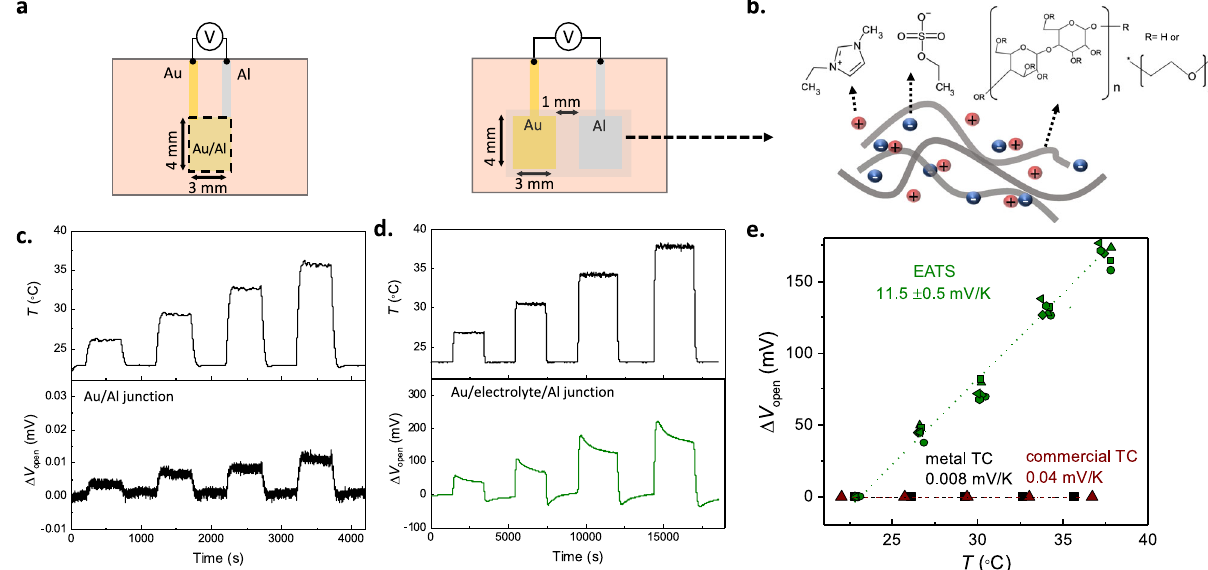
Fig. 1 Demonstration of the EATS and comparison with traditional TCs. a Schematic illustration of an Al/Au junction (left) and the EATS device (right). The Al/Au junction device consists of 20 nm-thick aluminum and gold layers overlapping in a 12 mm 2 area. For the EATS device, the Au and Al electrodes are separated and bridged by an electrolyte (shaded region, with areas overlapping with the electrodes of 12 mm 2 ). b Schematic illustration of the gel-like electrolyte used in EATS a and the chemical structures of the compositions in the gel. c Variations in open-circuit voltage of an Al/Au junction (bottom panel) upon controlled temperature changes (top panel). d Variation in open-circuit voltage of an EATS (bottom panel) upon controlled temperature changes (top panel). e Change in open-circuit voltage versus temperature for six EATS devices and comparison with the Al/Au junction (black squares) and a commercial TC (red triangles). Different green symbol shapes indicate the results from different samples, and the error is the standard deviation from these six samples. The results were obtained in a cleanroom with relative humidity (RH) of